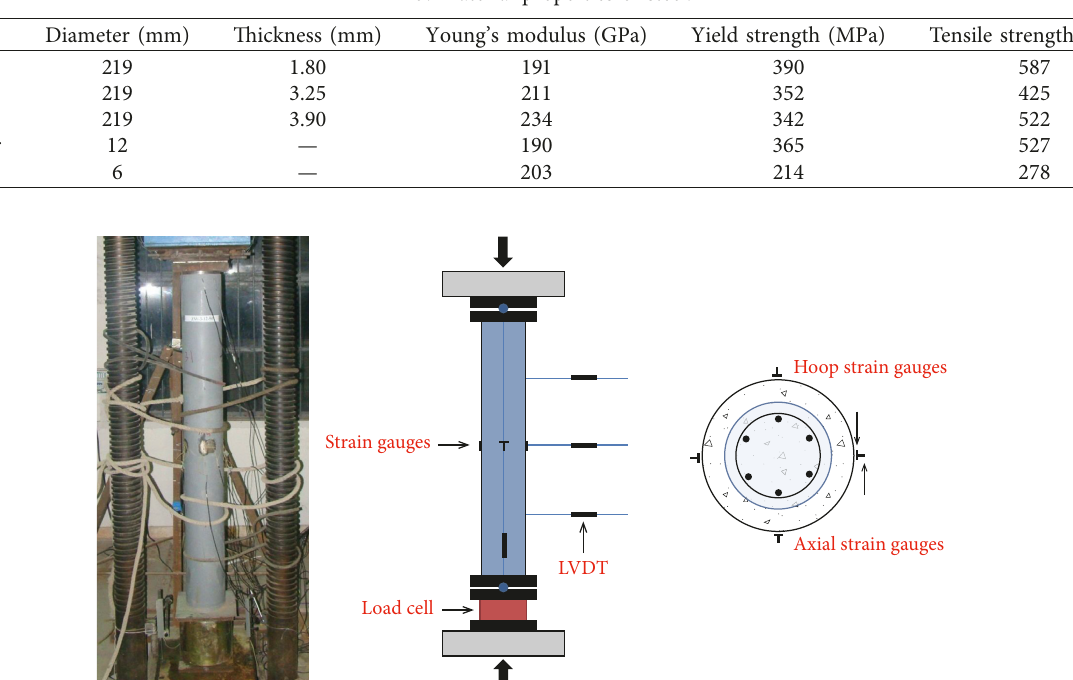
Figure 1: Test setup and instrumentation.